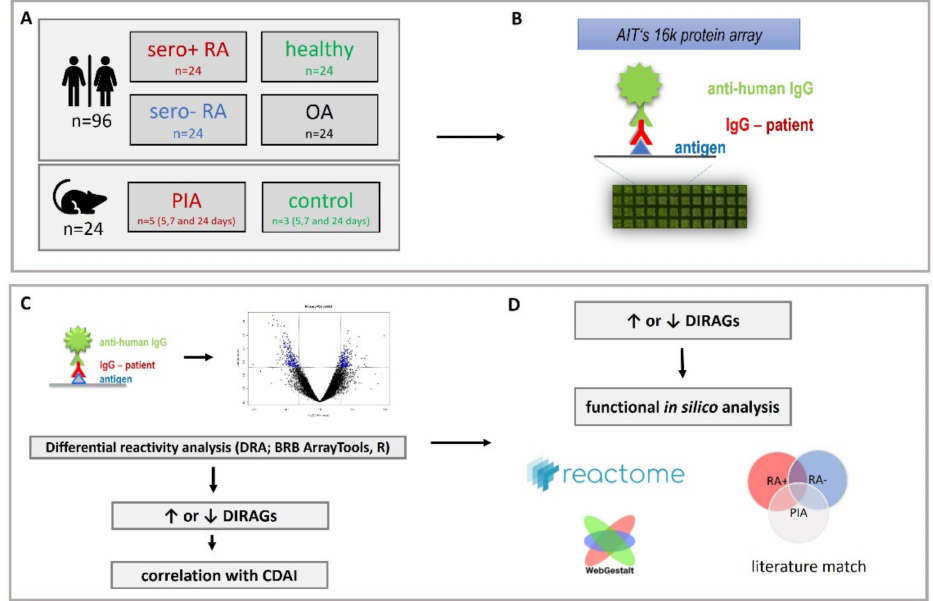
Figure 1. Study design. ( A ) sample cohort: 96 samples from RF- and CCP-positive (sero+), RF- and CCP- negative (sero-) RA, osteoarthritis and healthy human individuals and 24 samples from time- course pristane induced arthritis (PIA) and control animals were investigated. ( B ) IgG isolated from plasma was probed on AIT’s 16k microarray. ( C ) Data obtained from microarray scans was subjected to differential reactivity analysis (DRA) and correlation analysis with clinical disease activity index (CDAI) using BRB ArrayTools and RStudio elucidating differentially reactive antigens (DIRAGs) which were subsequently ( D ) in silico analyzed for dysregulated